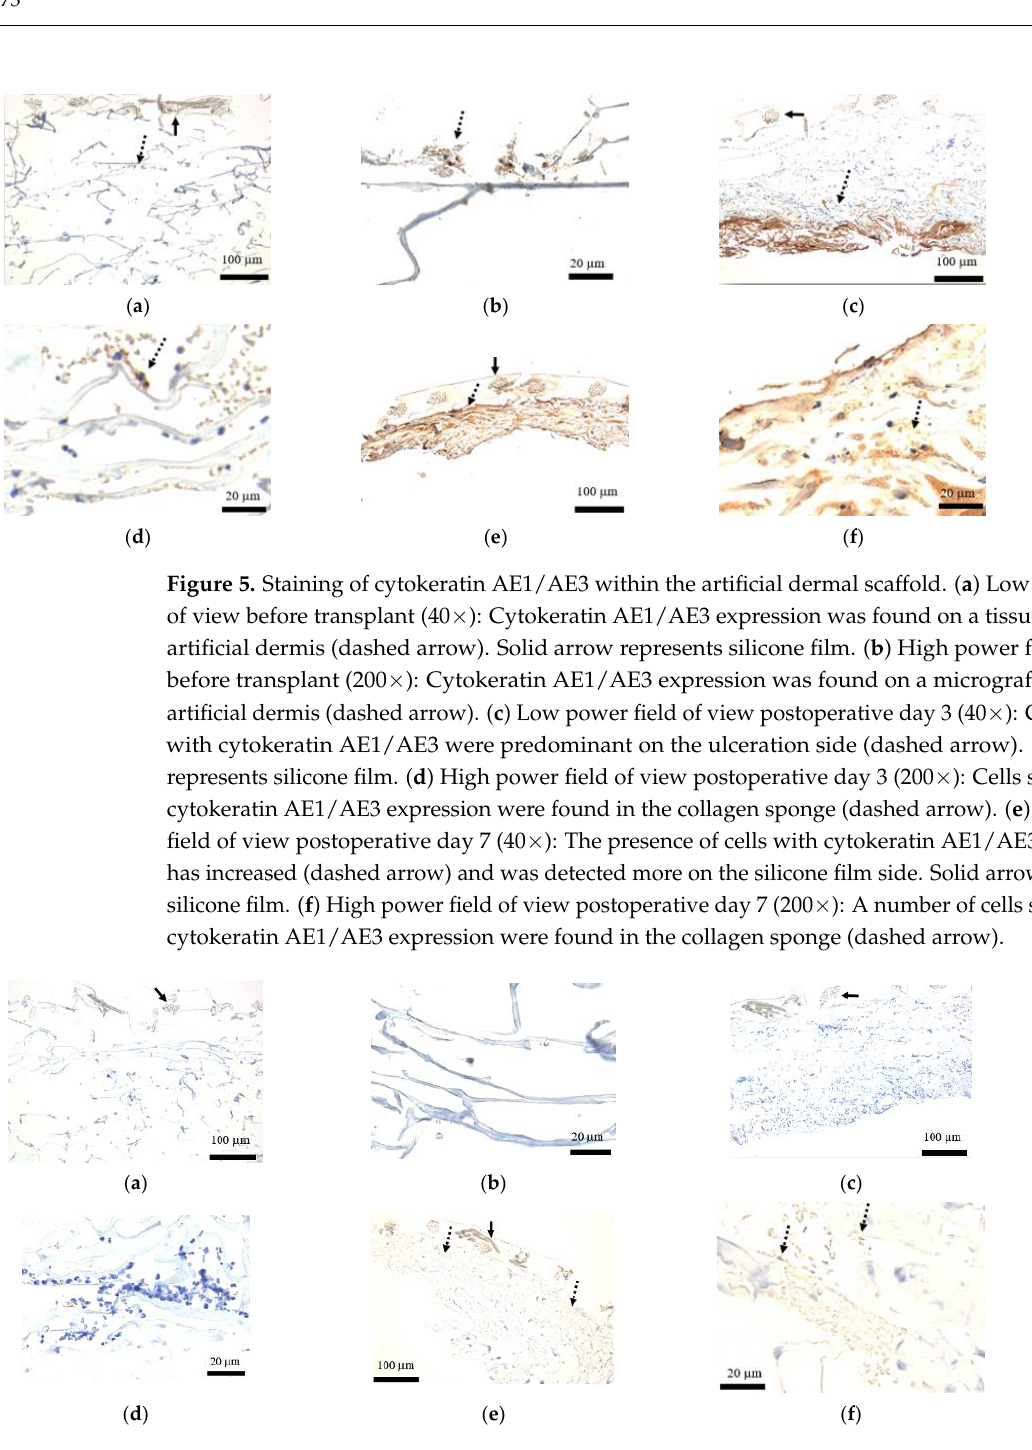
Figure 6. Staining of desmin within the artificial dermal scaffold. ( a ) Low power field of view before transplant (40 × ): No tissue within the collagen sponge was stained with desmin. Solid arrow represents silicone film. ( b ) High power field of view before transplant (200 × ): No tissue within the collagen sponge was stained with desmin. ( c ) Low power field of view postoperative day 3 (40 × ): No tissue within the collagen sponge was stained with desmin. Solid arrow represents silicone film. ( d ) High power field of view postoperative day 3 (200 × ): No tissue within the collagen sponge was stained with desmin. ( e ) Low power field of view postoperative Day 7 (40 × ): A slight positivity with desmin was seen within part of the collagen sponge (dashed arrow). Uneven distribution was not seen among the stained cells. Solid arrow represents silicone film. ( f ) High power field of view postoperative day 7 (200 × ): A slight positivity with desmin was seen within part of the collagen sponge (dashed